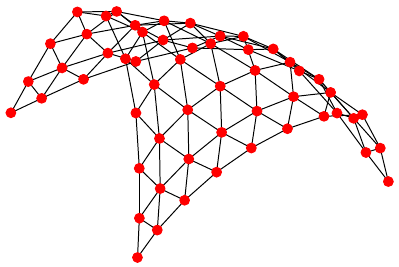
Figure 6. Communication and structure layers of Structure 1.